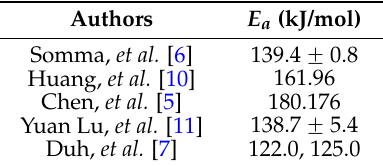
Table 5. Apparent activation energy values of CHP obtained from the